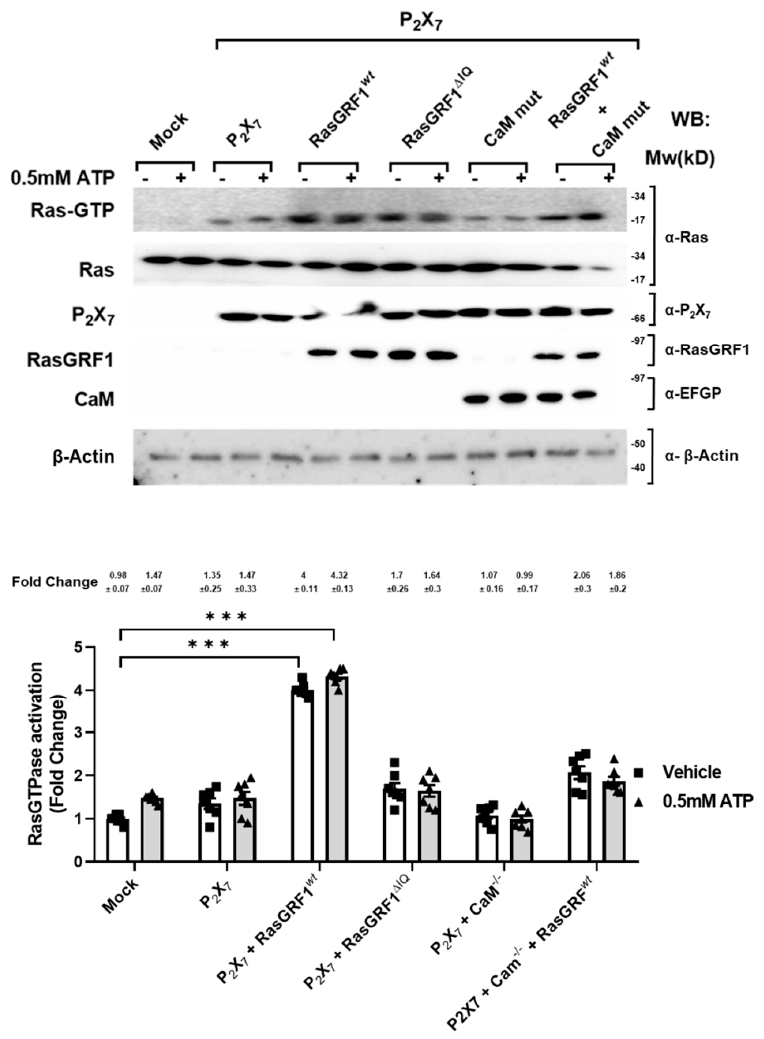
Figure 3. The P2X 7 receptor requires CaM/RasGRF1 pathway to activate Ras in HEK 293 T cells. The HEK 293 T cells were transfected with empty vector (mock control), pCELF-HA-P2X 7 receptor, or co-transfected with the P2X 7 receptor, together with pEGFP-RasGRF1wt, pEGFP-RasGRF1mutIQ, or pcDNA3YFP-CaM mut, or with a combination of the pEGFP-RasGRF1wt and pcDNA3YFP-CaM mut. Forty-eight hours post-transfection, cells were treated, or not, with 0.5 mM ATP for 5 min and lysed. Cell lysates were used to measure Ras activation by the affinity precipitation assay. The precipitated active Ras (Ras-GTP), total Ras, P2X 7 receptor, RasGRF1wt, RasGRF1mutIQ, and CaM mut expression levels were analyzed by Western blotting using specific antibodies. The β -Actin amounts present in the samples analyzed in lower panel were examined with an anti- β -Actin antibody. Immunoblots are representative of five independent experiments. Each histogram bar includes the values of seven different samples. All values are expressed in fold change. The differences between treatments were p < 0.001 in all cases